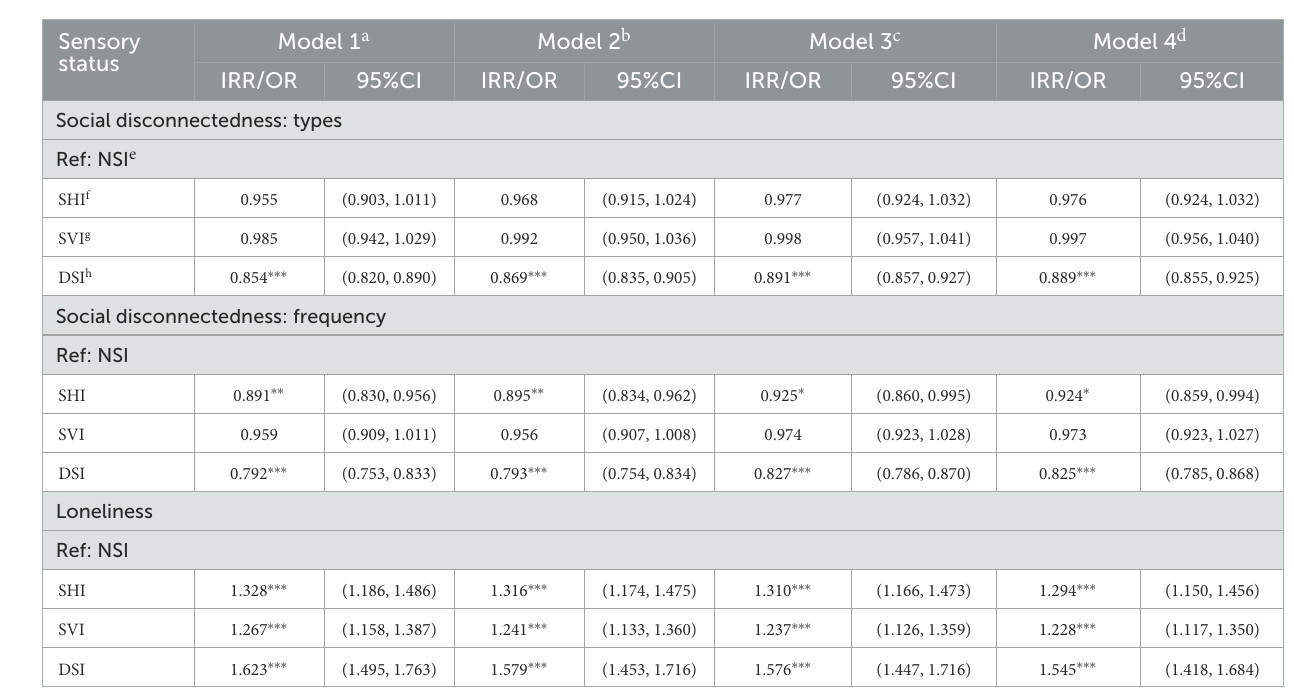
TABLE 4 Longitudinal generalized linear analysis of sensory impairments and social isolation,